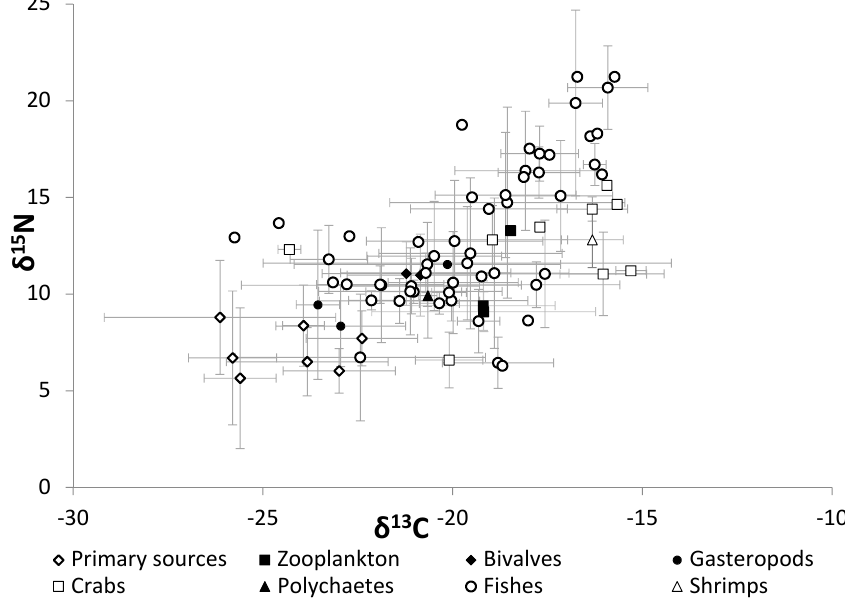
Figure 2. Relationships between mean δ 13 C (‰) versus mean δ 15 N (‰) in food sources (primary producers) and predators (zooplankton, macroinvertebrates, and fish) in the wetland of Teacapan.